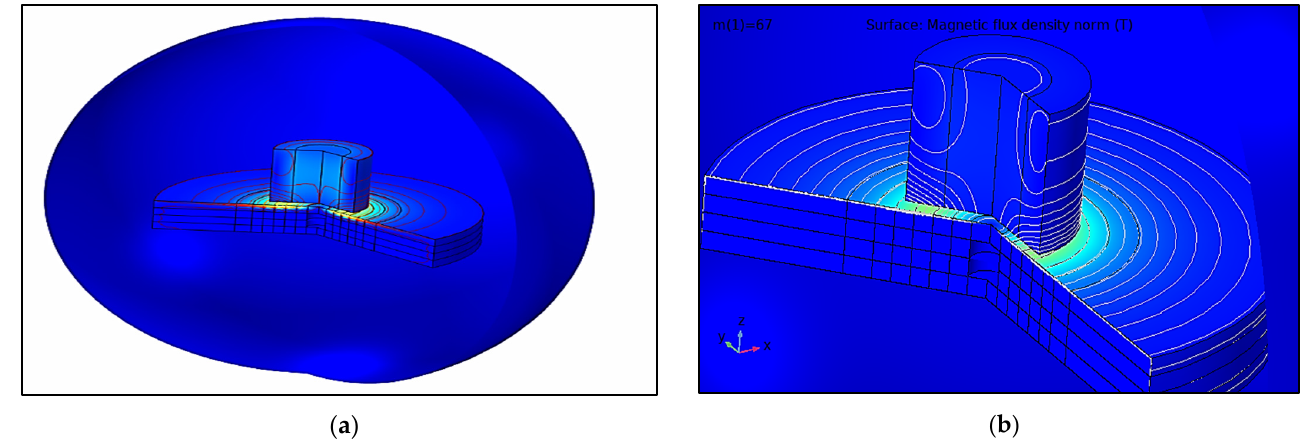
Figure 5. ( a ) The 2-D axisymmetric FE model, and ( b ) the solution for coil parameters at 100 kHz frequency.